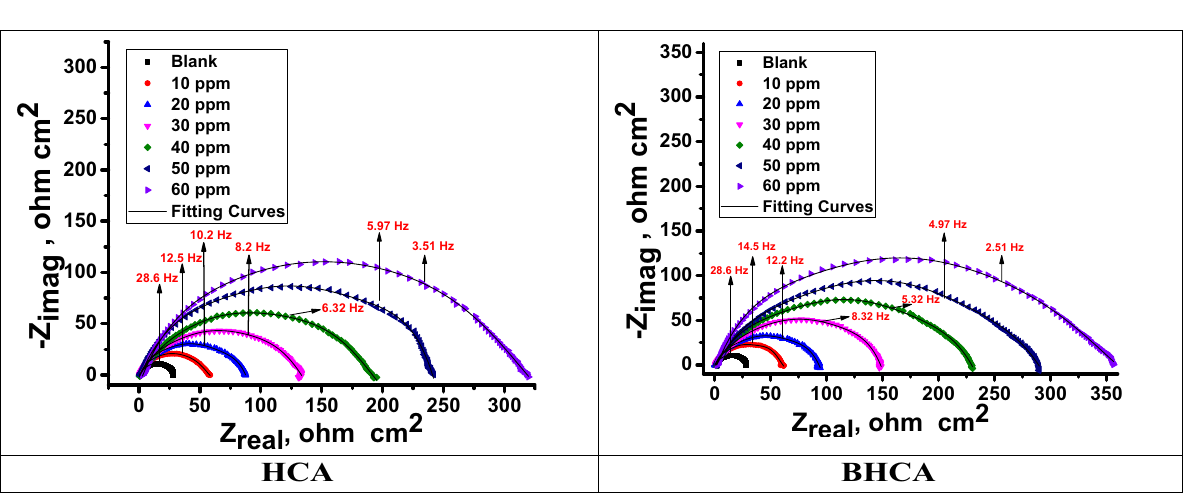
Figure 9. The Nyquist bends for dissolution of CS in 1 M HCl in the absence and with altered doses of HCA &BHCA at 298 K.